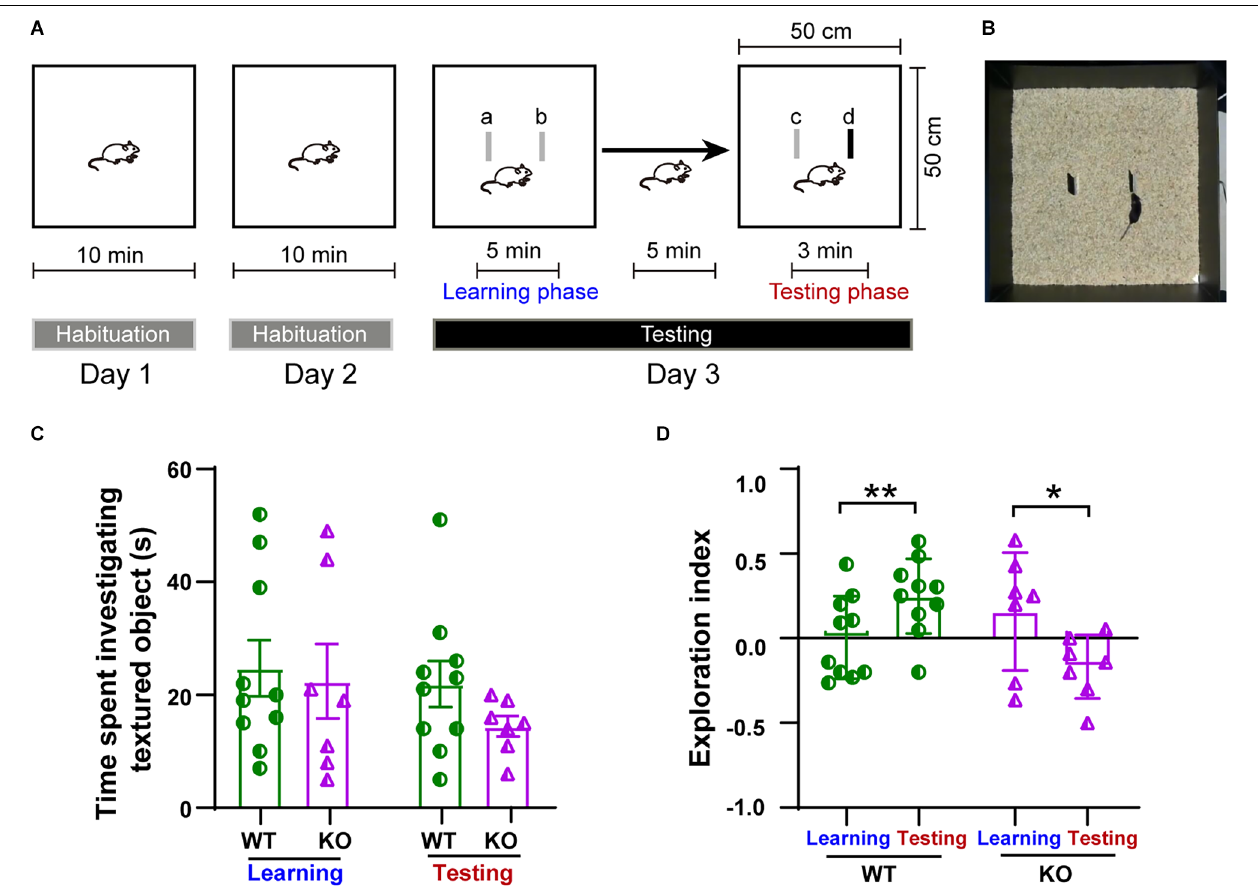
FIGURE 7 | Impairment in whisker-dependent novel texture discrimination task in p53KO mice. (A) Schematic of the protocol for the texture discrimination task. (B) Photograph of the testing apparatus. (C) Total time mice spent investigating the texture ( F (3,30) = 0.8077, p = 0.4996, one-way ANOVA followed by post hoc Tukey’s test). (D) Scatter plot showing exploration index for animals in (C) : WT (paired t -test: t (9) = 4.206, p = 0.0023; one-sample t -test: WT learning, t (9) = 0.0602, p = 0.9533; Wt-testing, t (9) = 3.561, p = 0.0061). KO (paired t -test: t (6) = 3.646, p = 0.0108; one-sample t -test: KO learning, t (6) = 1.197, p = 0.2763; KO testing, t (6) = 2.374, p = 0.0552). * p < 0.05; ** p <